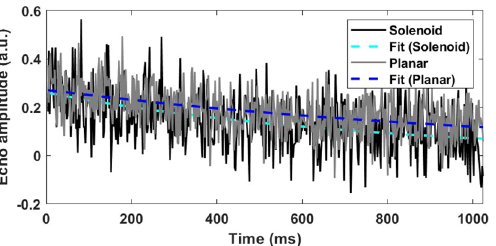
Figure 9. Measured echo decays from an Acetaminophen sample, displaying the contrast in T 2, eff values between the solenoid and planar